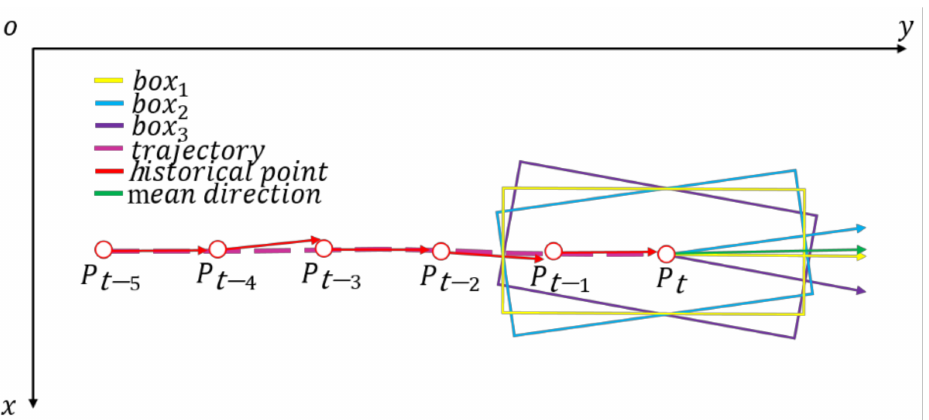
Figure 17. Illustration of direction angle association evaluation index. P t represents the current moment, P t − 1 − P t − 5 represent the historical trajectory points of this obstacle in the previous five frames, and the direction of the green arrow represents the average direction of the previous five frames. At the P t moment, the bounding boxes of the three pose estimation methods are shown. According to the direction angle association index, the pose estimation direction of box 1 is the closest to the historical average direction. Thus, the box 1 is the best pose estimation result from three methods in this